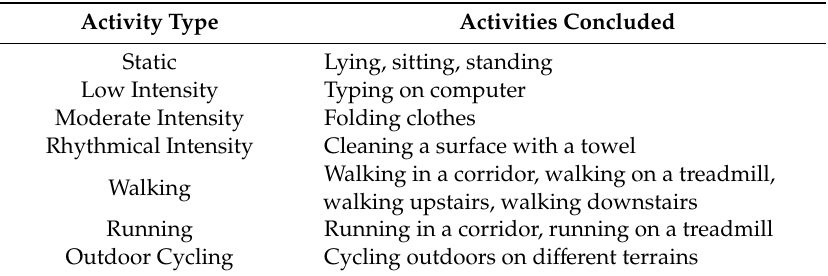
Table 2. Classified activity